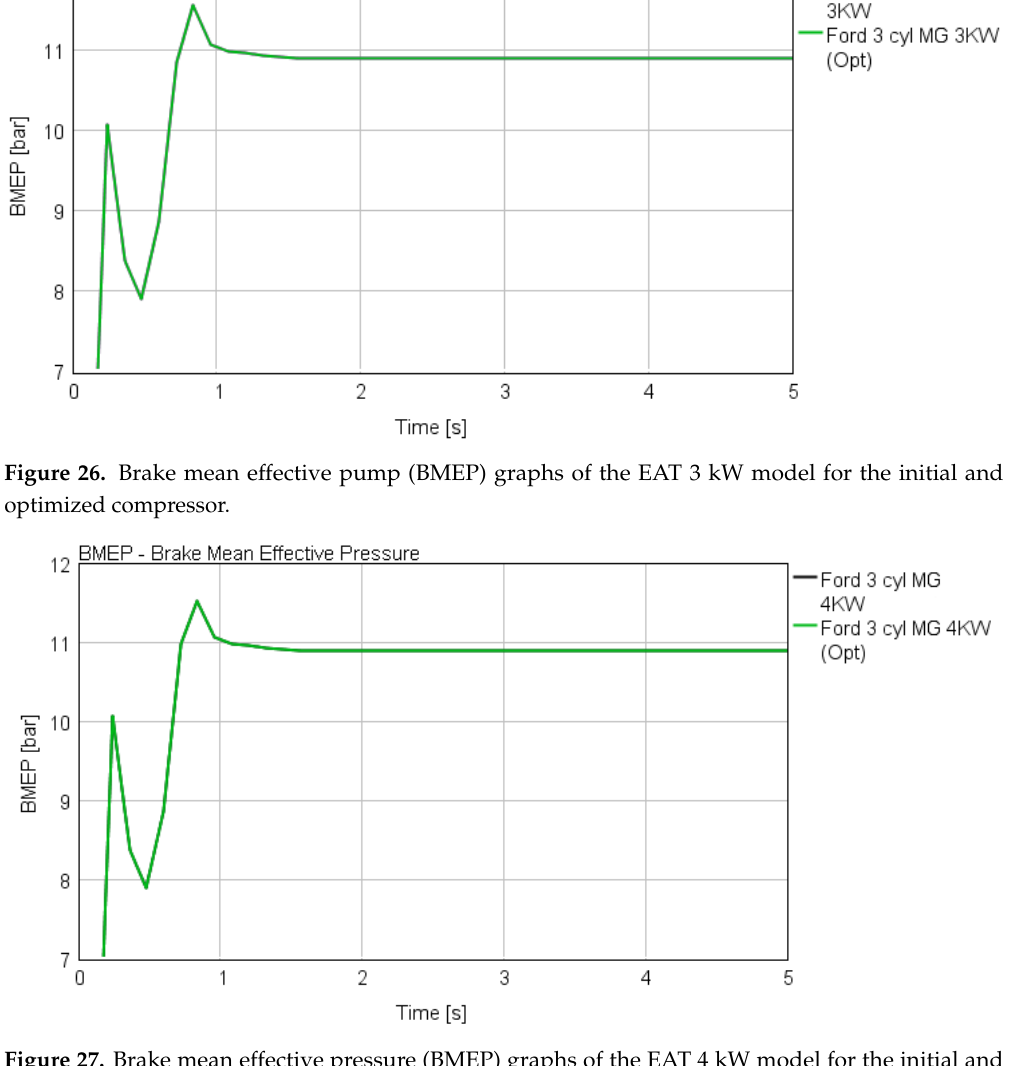
Figure 28. Brake torque graphs for the initial (black) and optimized (green) EAT 5 kW models.